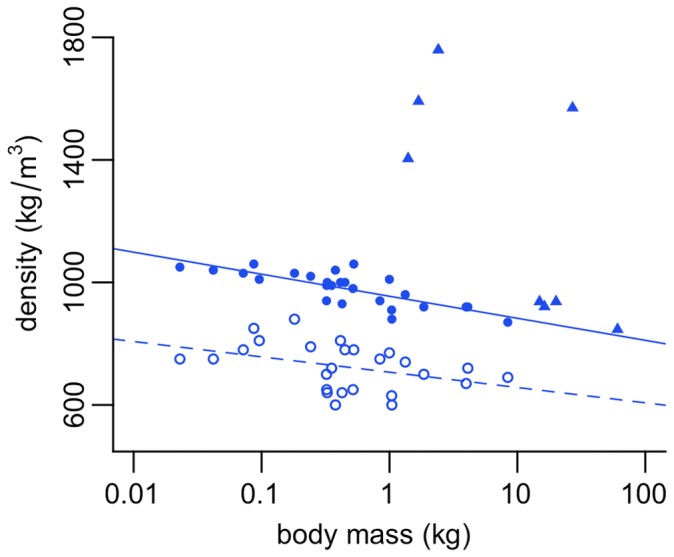
Scaling of density against mass in birds.Feathered carcass density (open circles) scales negatively against body mass (a = 707, b = −50.4, r
2 = 0.16, p = 0.04). Plucked carcass density (closed circles) scales negatively against body mass (a = 955. b = −72.4, r
2 = 0.61, p<0.001). Note the extremely weak correlation between feathered body density and mass, compared to the much stronger correlation between plucked carcass density and mass (see text for further discussion). Feathered and plucked carcass data from Budgey (2000). Convex hull density in birds also given for reference (closed triangles).